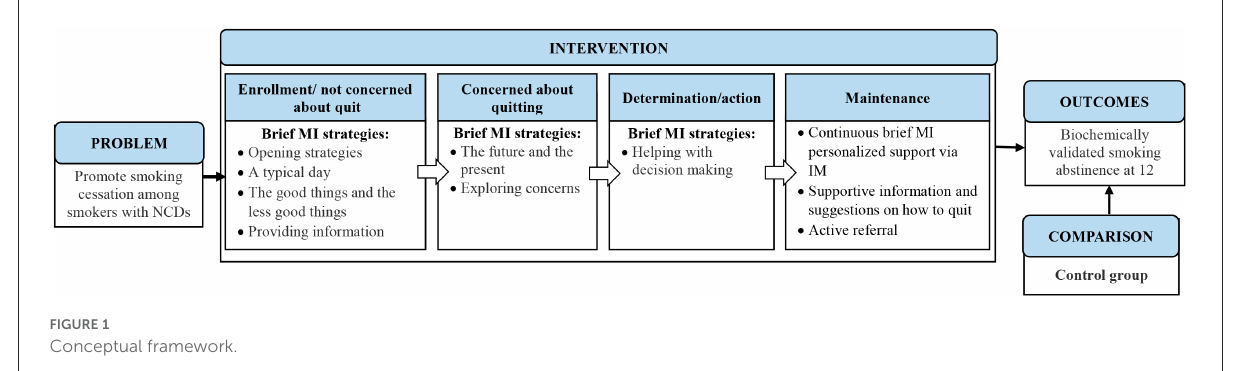
FIGURE1 Conceptual framework.